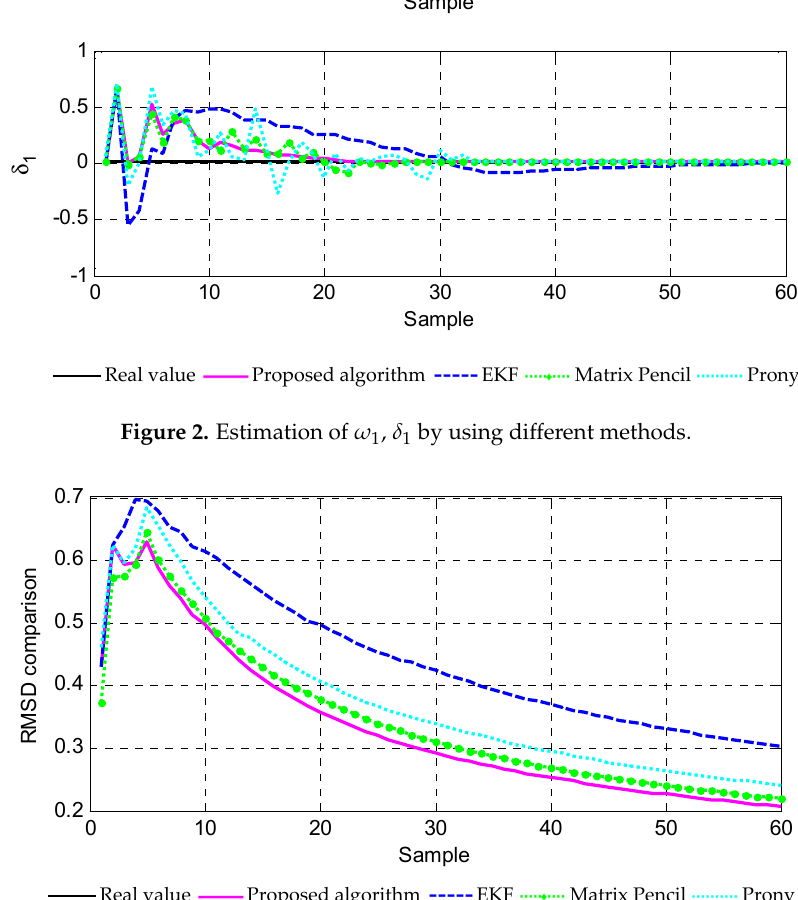
Figure 3. Comparisons of average estimation errors.